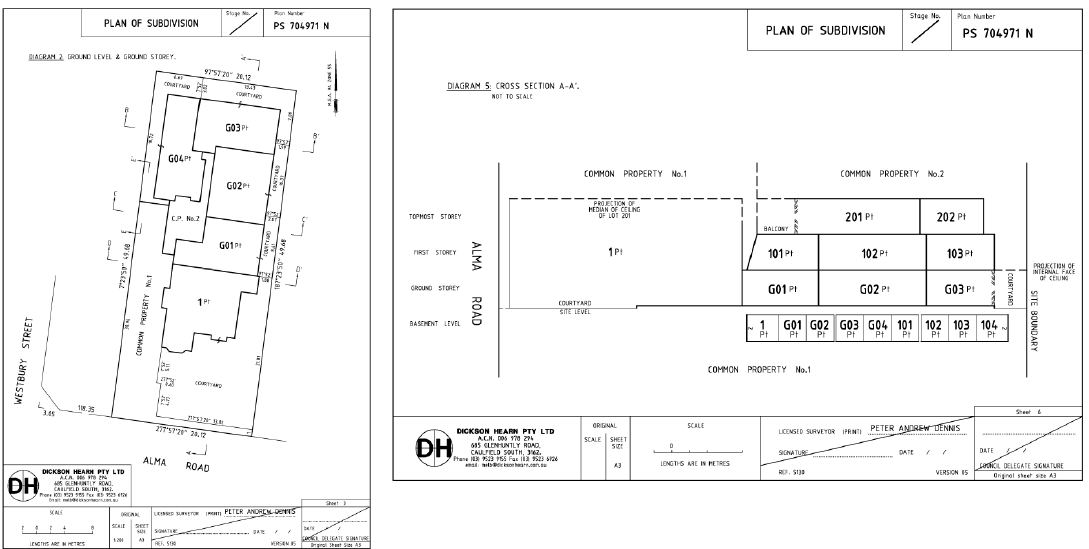
Figure 6. Screenshots of building subdivision plan PS704971N.